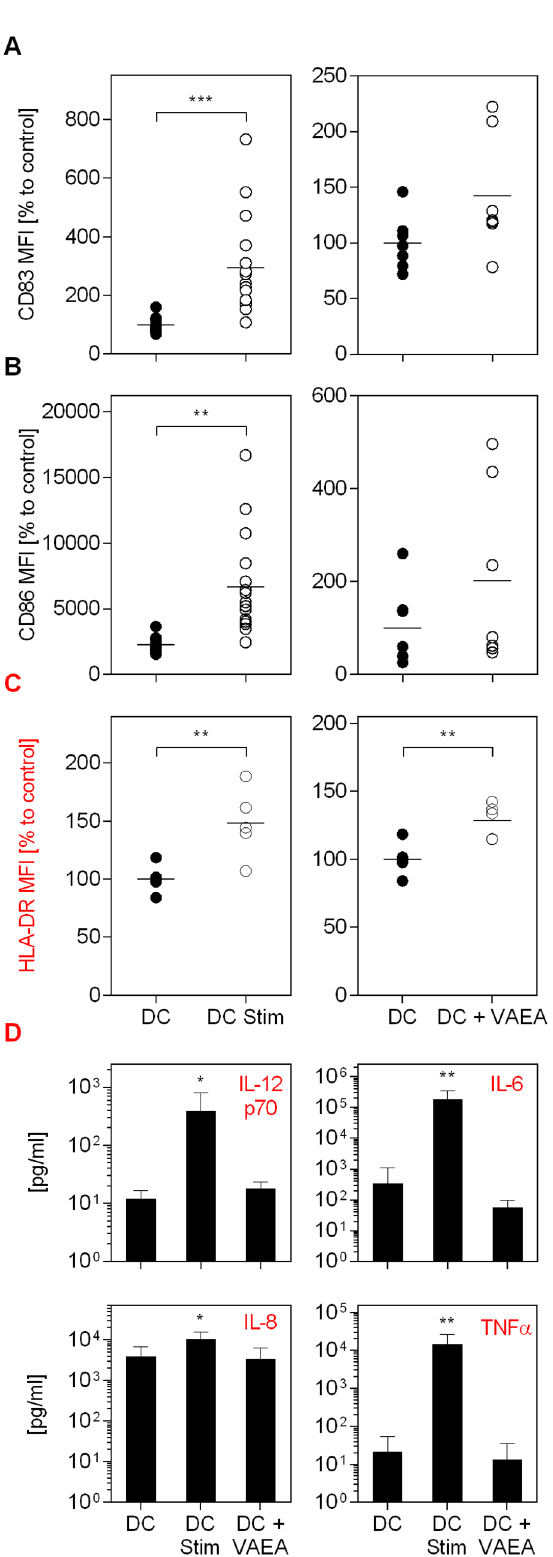
Fig 2. Influence of VAEA on DC maturation and cytokine secretion. CD14 + monocyteswere matured to immature DC and incubatedwith medium (DC), maturation cocktail (DC Stim; 500 ng/mL LPS; 50 ng/mL